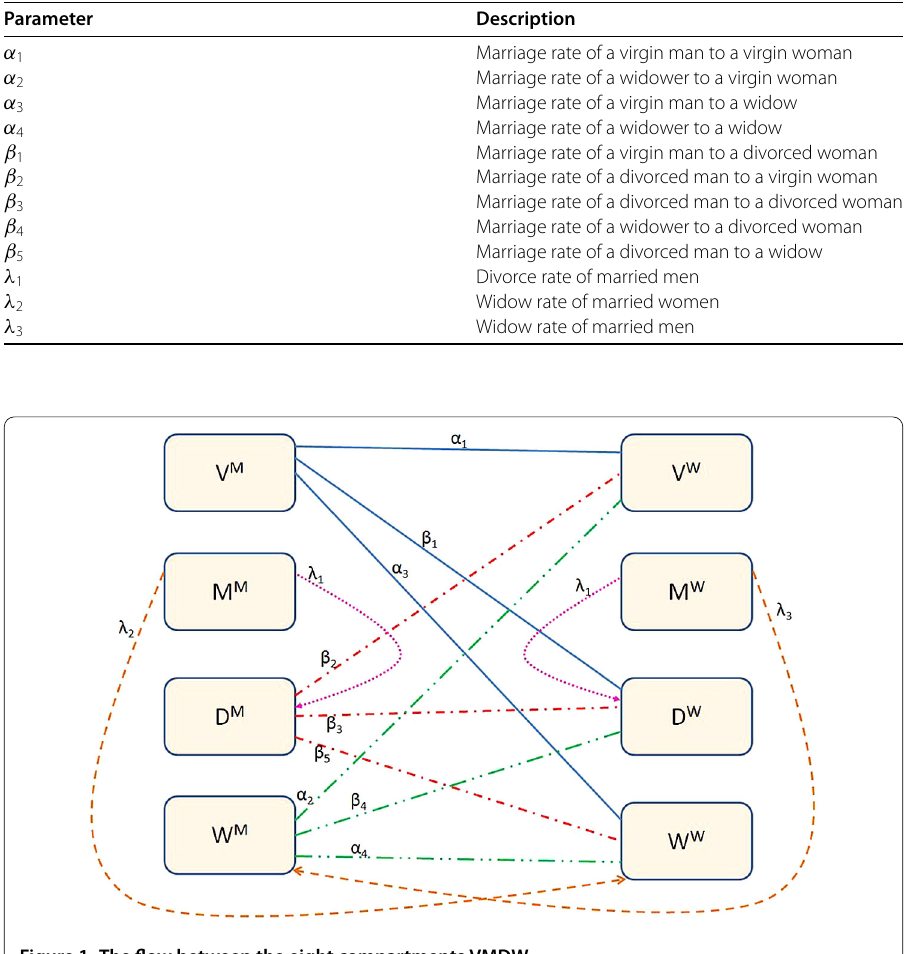
Figure 1 The flow between the eight compartments